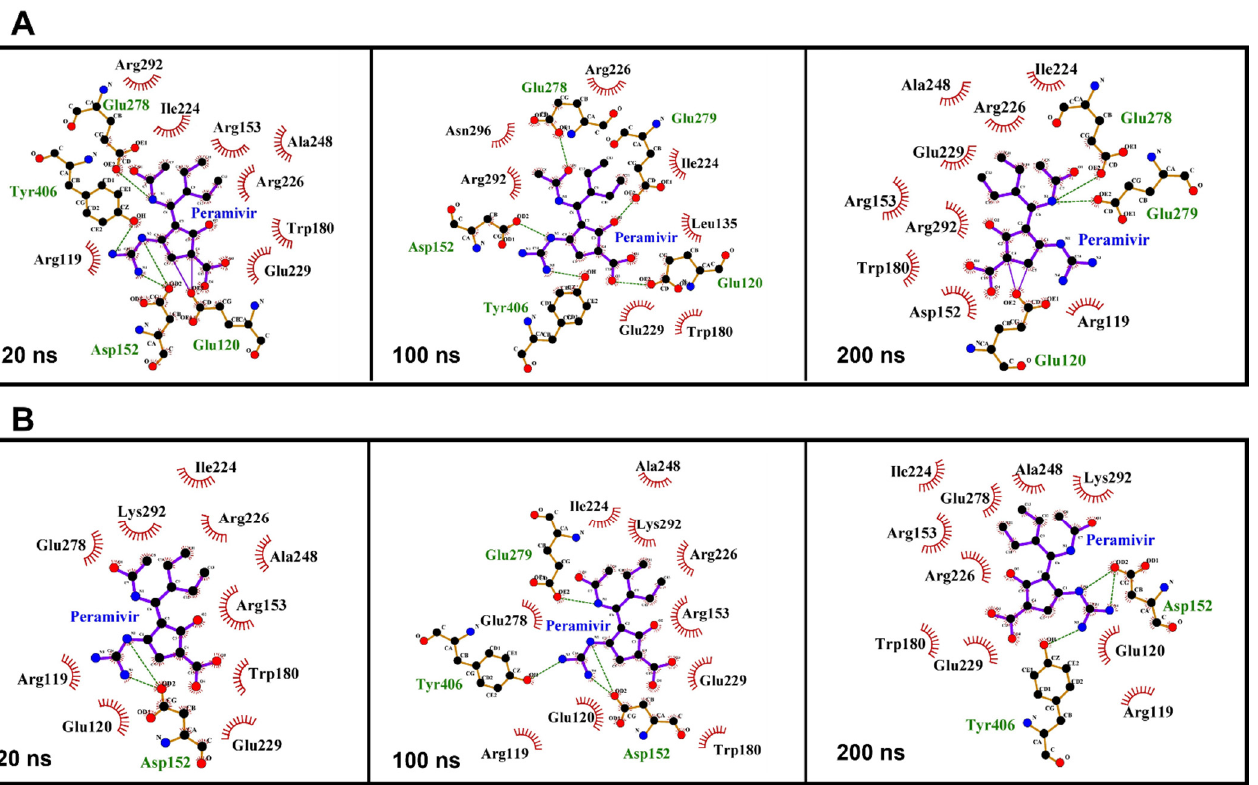
Figure 6. Amino acid residue interactions with peramivir in the active site of the wild-type ( A ) and R292K mutant ( B ) at 20 ns, 100 ns, and 200 ns simulation time.